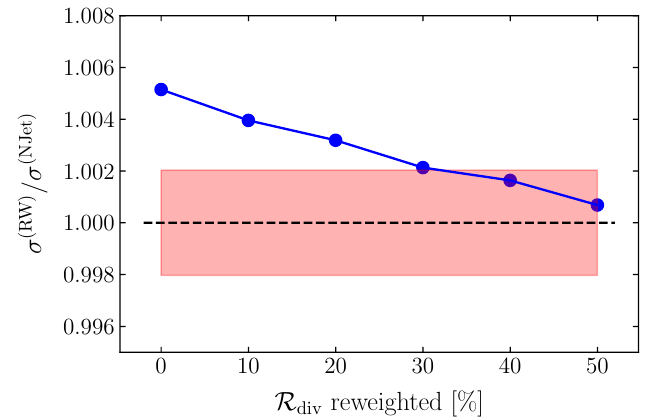
Figure 4. Effect of reweighting points in the divergent region of phase space, R div , on the ratio between the reweighted cross section, σ (RW) , and the cross section calculated using NJet σ ( NJet ) for the 2 → 3 process. In this case, the divergent region comprises approximately 7–9% of the total phase space (see appendix B for details). The red band shows the MC error on the NJet result.